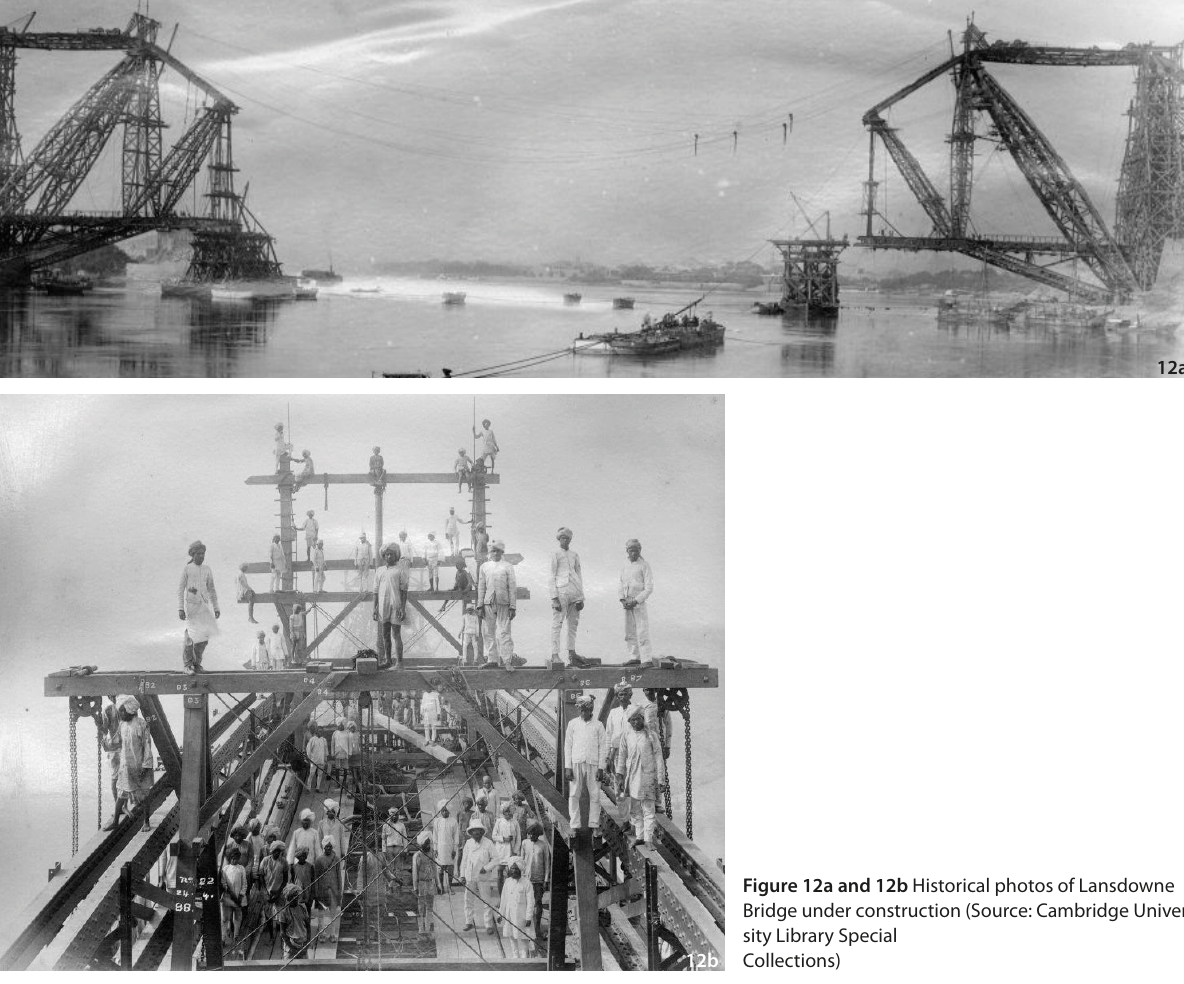
Figure 12a and 12b Historical photos of Lansdowne Bridge under construction (Source: Cambridge Univer- sity Library Special